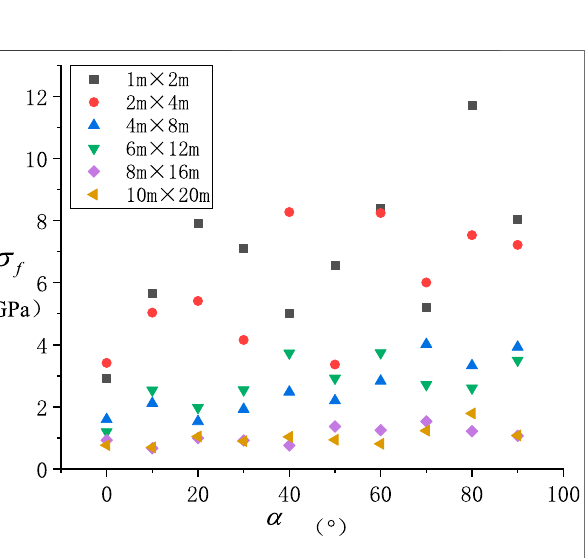
FIGURE 9 | Relationship Between Sample δ and Main Joint Angle α